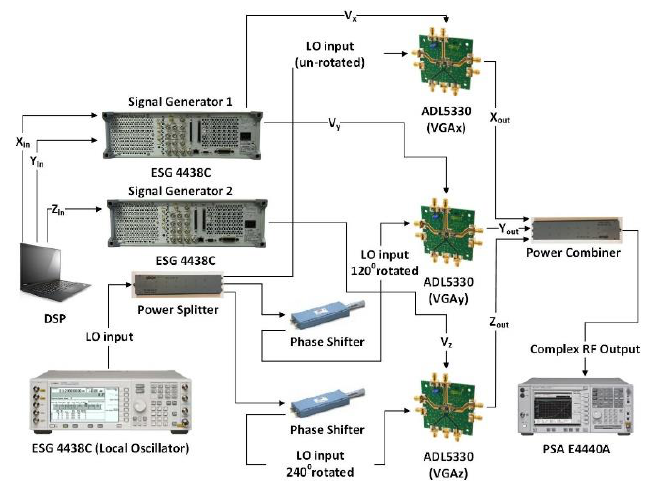
Figure 7. Implementation of the mixer-less three-way amplitude modulator-based transmitter using phase shifters and analog combining.